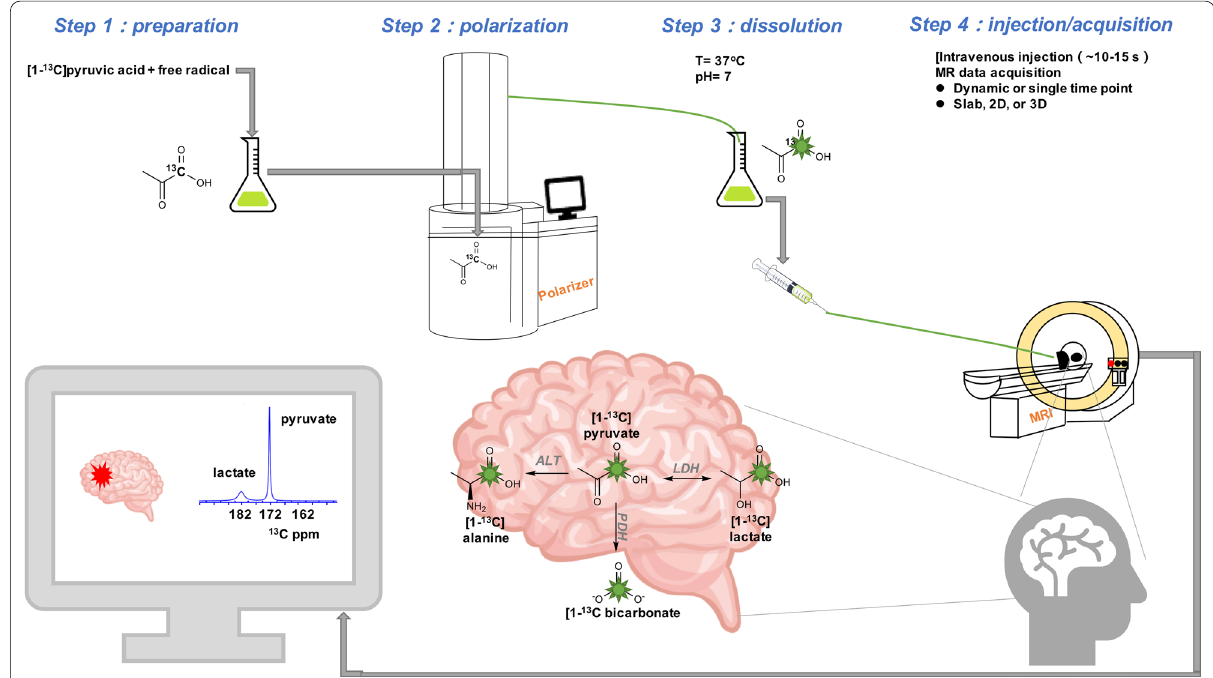
Fig. 1 The workflow of hyperpolarized carbon-13 MRI in biomedical